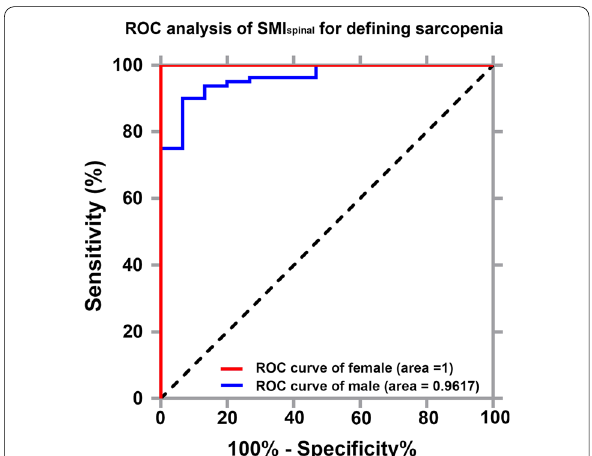
Fig. 3 Receiver operating characteristic curve analysis of SMI spinal index cut-off values for defining sarcopenia. SMI spinal skeletal